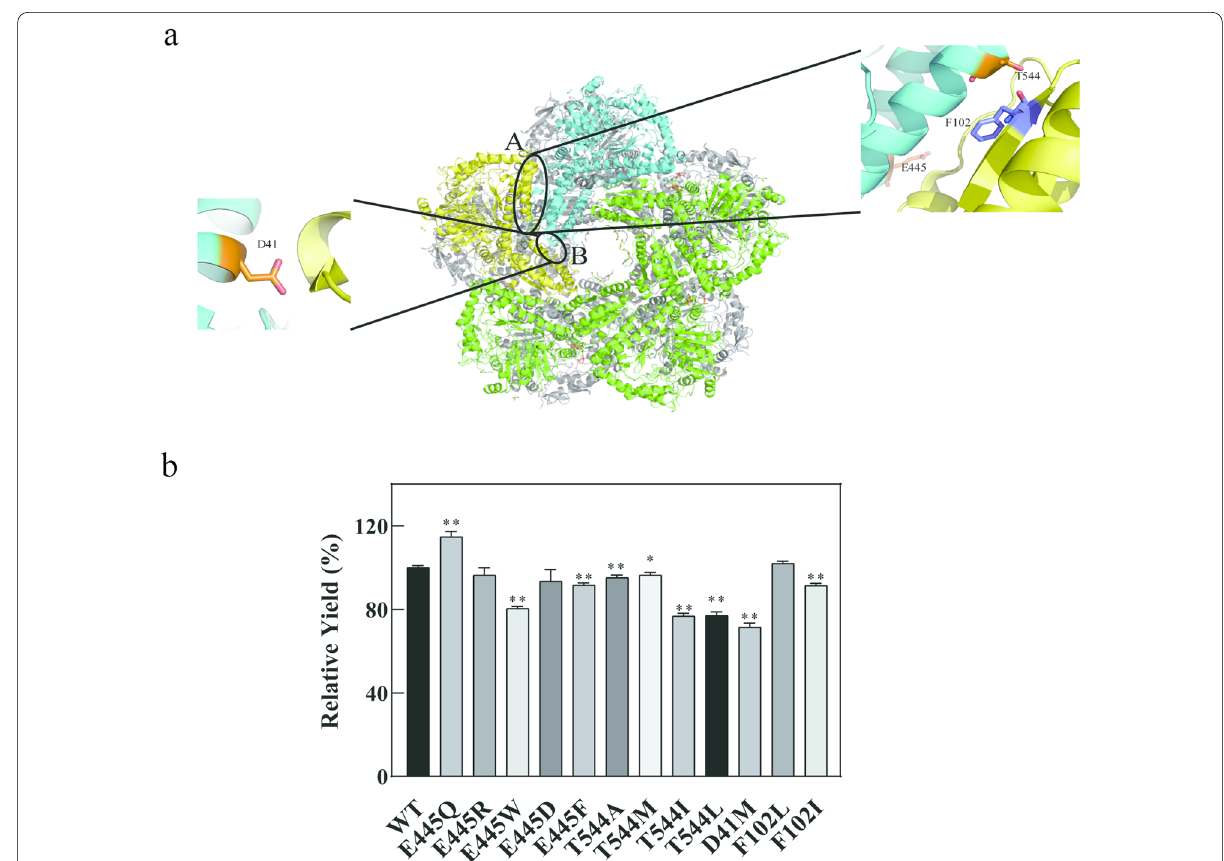
Fig. 3 Computational saturation mutagenesis of the decamer interface of CadA. a The decamer interface region of CadA is a decamer composed of five dimers. F102, E445, and T544 are located in interfacial region A, while D41 is located in interfacial region B. b Experimental verification results of the mutants with improved stability as predicted by virtual screening. The error bars represent standard deviations calculated from triplicate experiments, and statistical significance of the different relative cadaverine yield in comparison with the wild type was evaluated using Student’s t test (*, P < 0.05, **, P < 0.01)